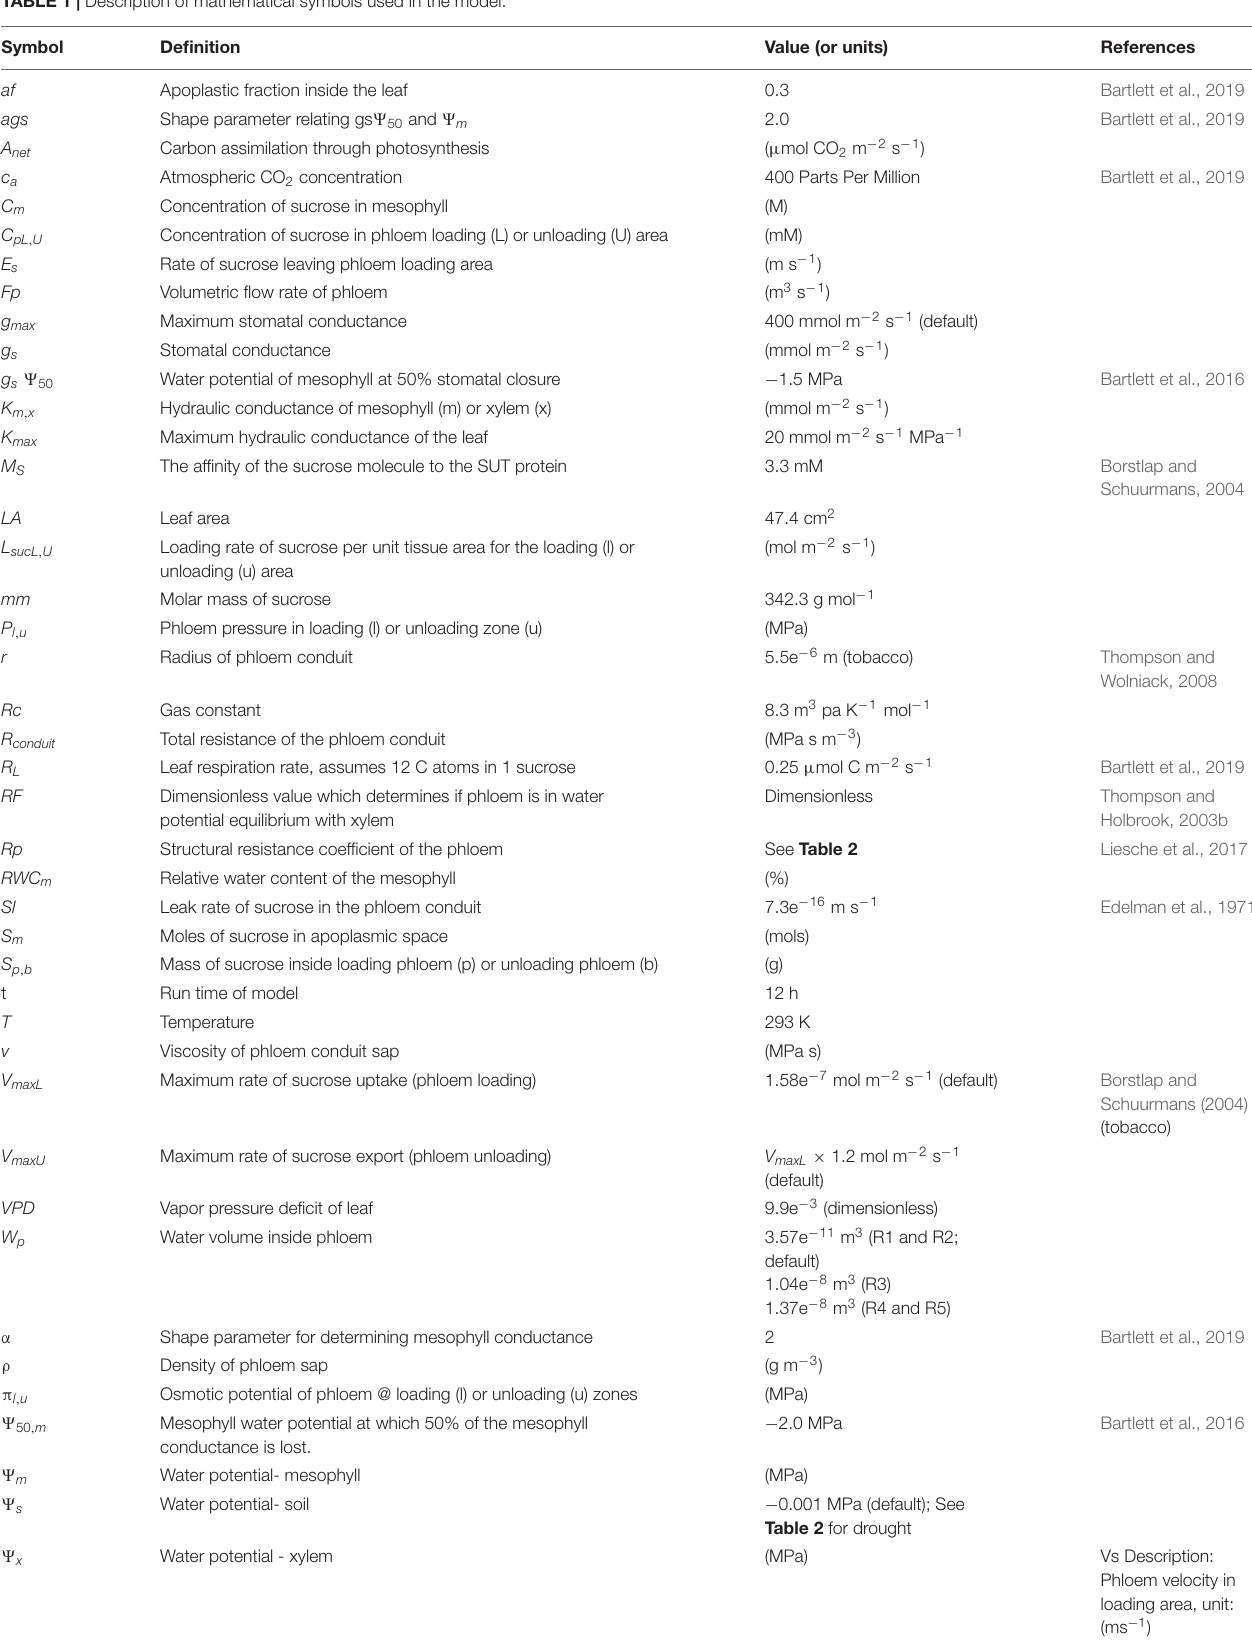
TABLE 1 | Description of mathematical symbols used in the